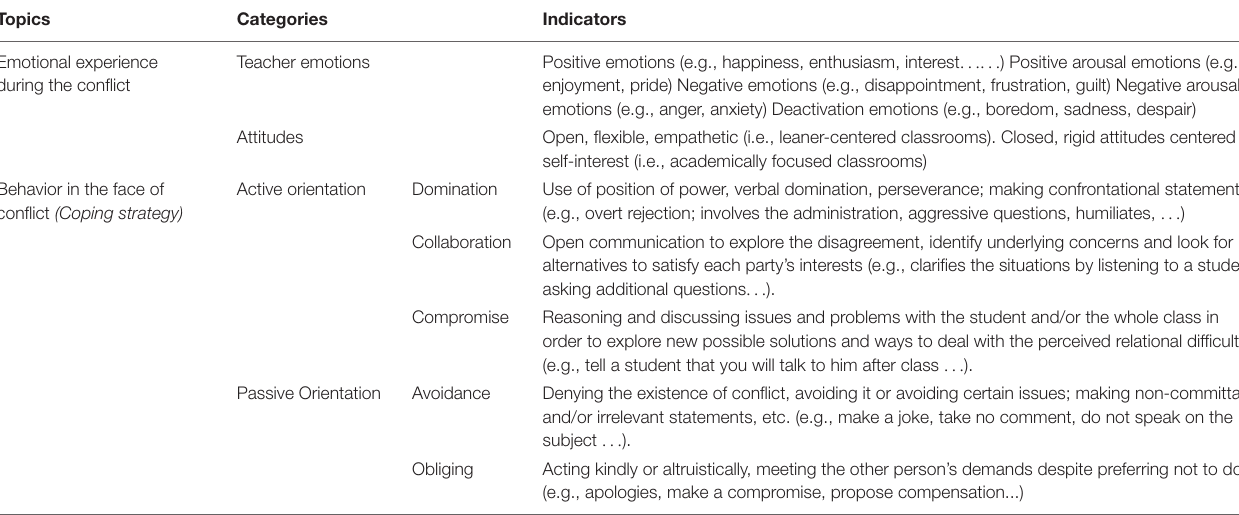
TABLE 1 | Topics, categories, and indicators that guided the summative case